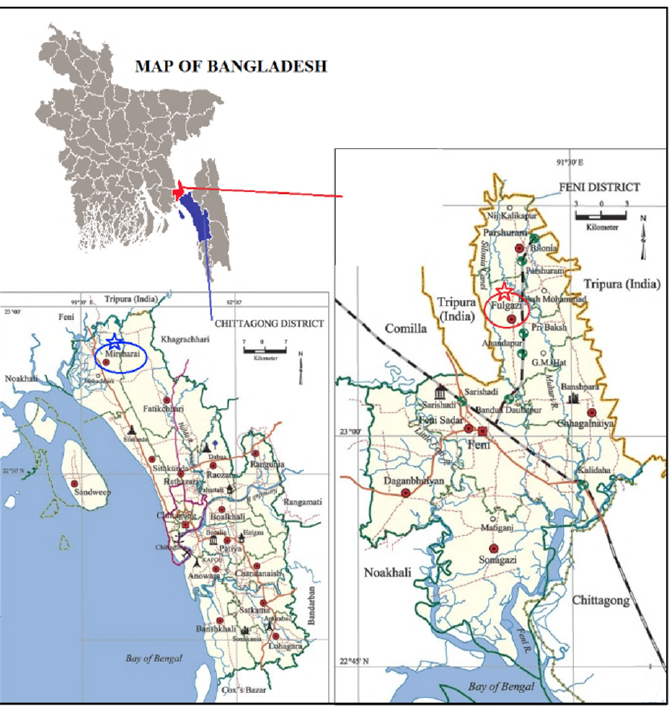
Figure 1. Locations of on-farm trials at Fulgazi, Feni, and Mirsharai, Chattogram, in Bangladesh. Table 1. Chemical properties of soil (0–15 cm depth) at study locations.